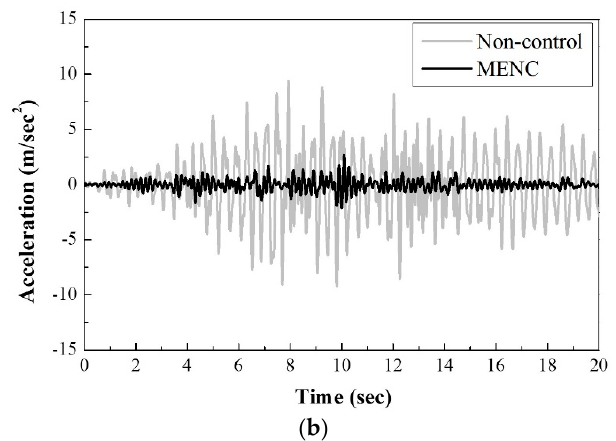
Figure 8. Comparison of control and non-control responses of the building structure under the California earthquake: ( a ) displacement; ( b ) acceleration.